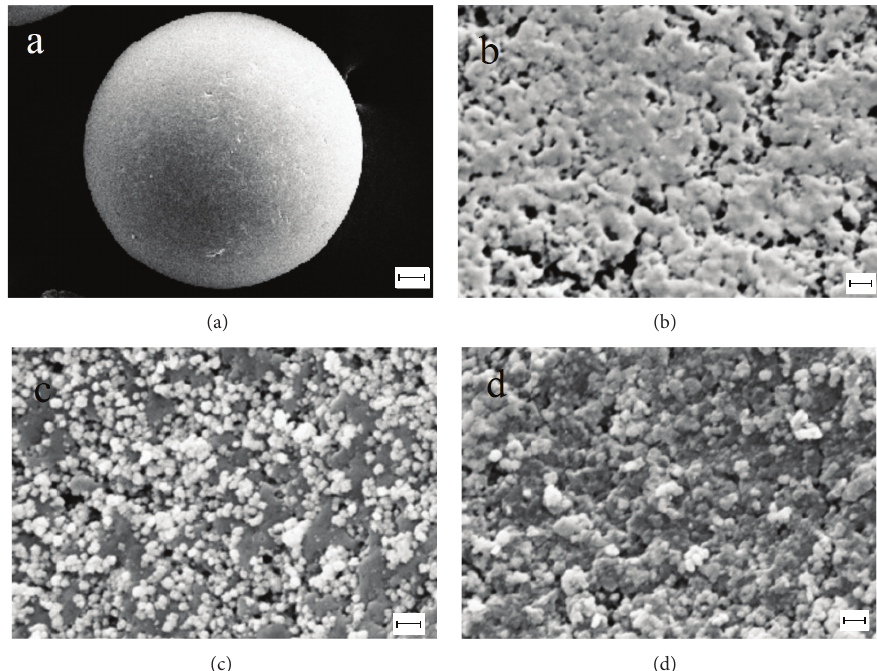
Figure 2: SEM images of (a) and (b) naked QuadraPure (scale bar 20 𝜇 m), (c) original XL-QPPd resin and (d) XL-QPPd after ten runs (scale bar: 200 nm).